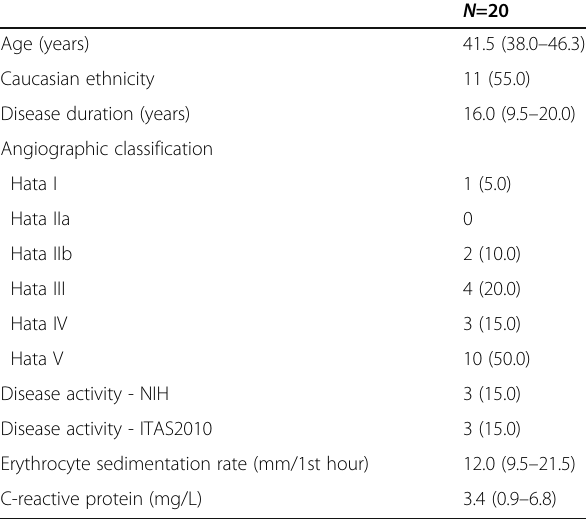
Table 1 General features of patients with Takayasu